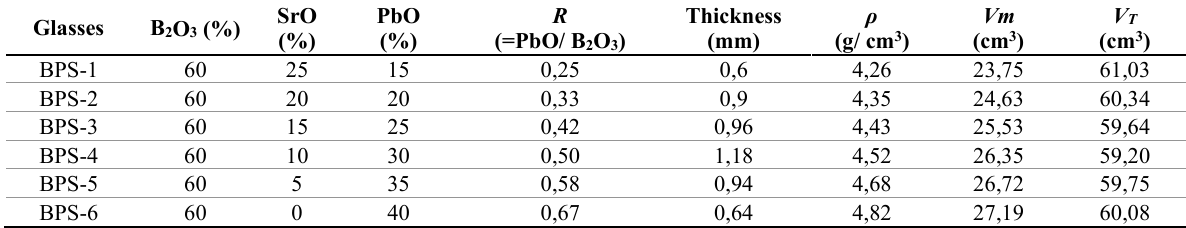
Table 1 C hemical composition (% molar), proportion of the content of PbO/ B 2 O 3 ( R ), thickness, density ( ρ ), molar volume ( Vm ) and glass sample packaging density ( V T